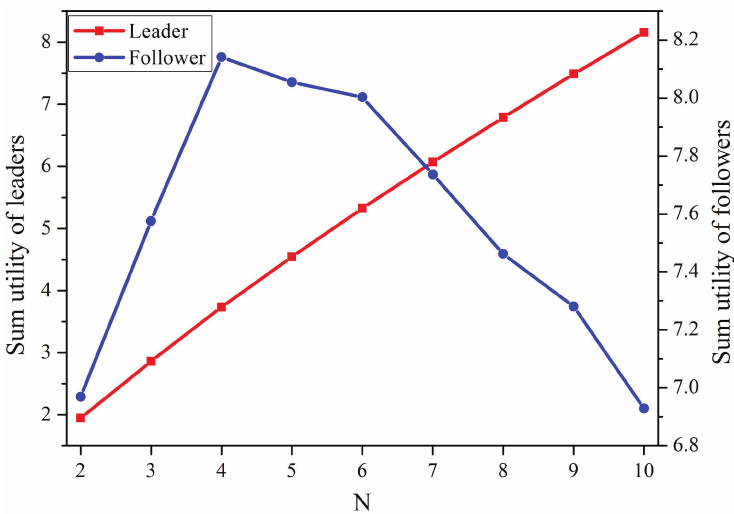
Figure 5. Sum utility of players vs. the number of co-located WBANs.